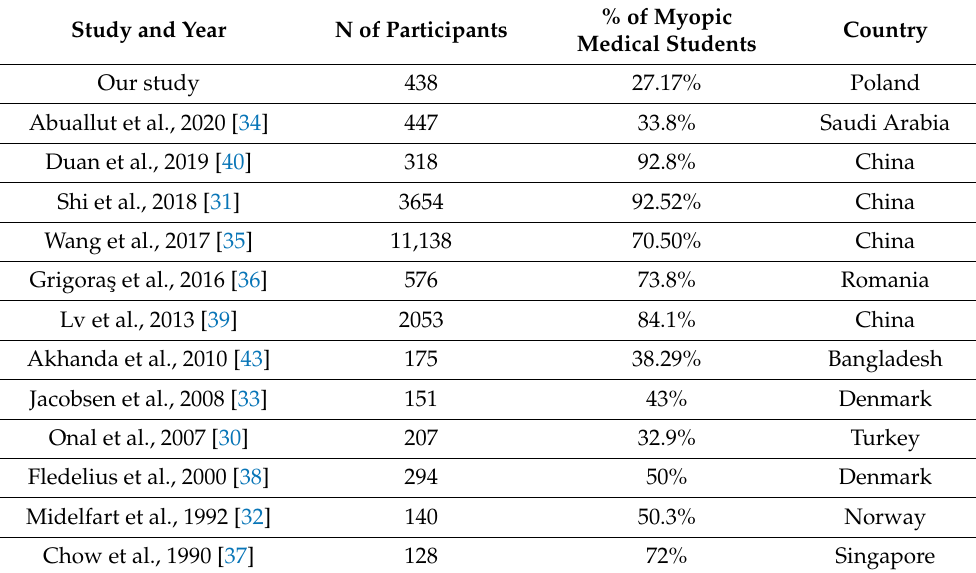
Table 5. Percentage of myopic medical students in different countries [30–40,43]. Study and